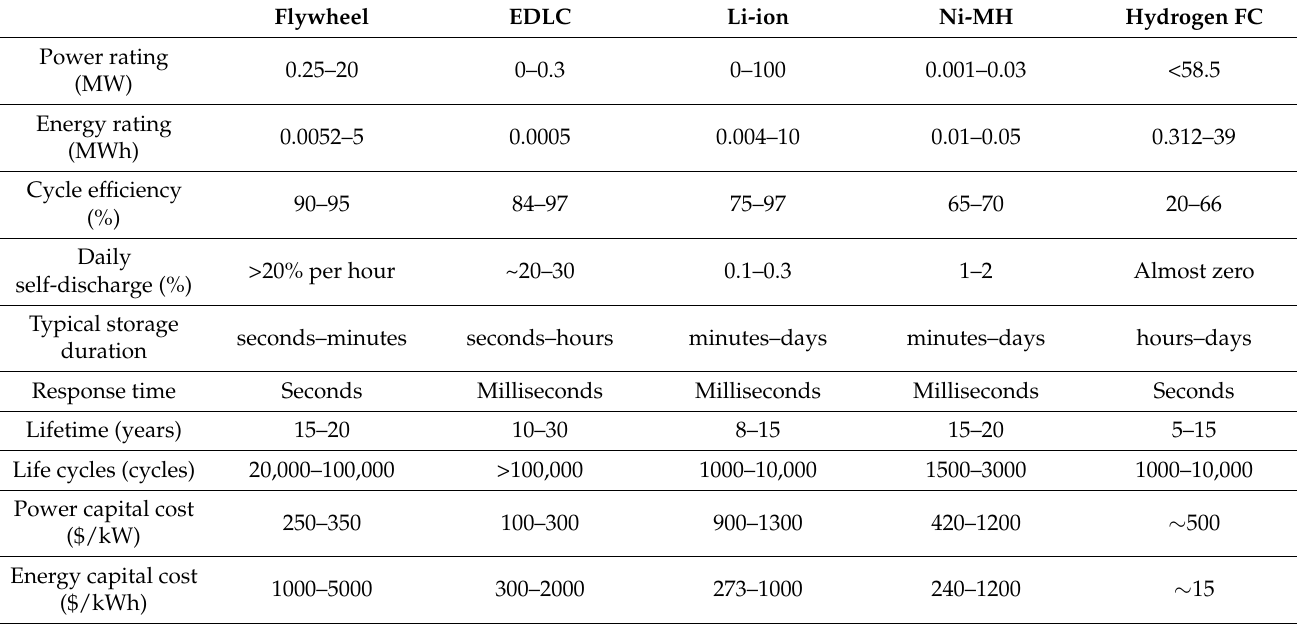
Table 2. Comparative characteristics of storage types